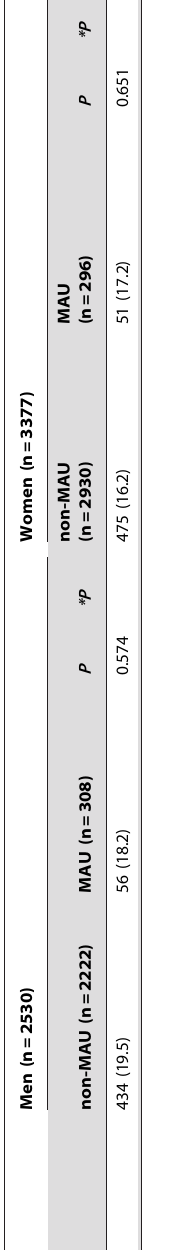
Basic Characteristics of Participants According to MAU (Table 1) Participants with MAU of both sexes were older than those without MAU (mean 6 SD; 57.1 6 10.9 y vs. 60.8 6 11 y, P , 0.001 in men; 57.7 6 10.6 y vs. 61.8 6 10.9 y, P , 0.001 in women). The proportion of poor lung function patterns differed between the MAU and non-MAU groups. The proportions of restrictive and obstructive patterns were higher in the MAU group than the non-MAU group (restrictive pattern: 20.1% vs. 10.2%, P , 0.001 in men; 14.2% vs. 9.3%, P = 0.004 in women; obstructive pattern: 27.3% vs. 22.5%, P = 0.002 in men; 8.8% vs. 6.0%, P = 0.033 in women). The percent predicted value of FVC in the non-MAU group was higher than that in the MAU group for both sexes (mean 6 SD: 91.8% 6 11.3 vs. 87% 6 12.2, P , 0.001 in men; 93.6% 6 11.5 vs. 91.1% 6 12.1, P , 0.001 in women). The percent predicted value of FEV1 in the non-MAU group was also higher than that in the MAU group for men (mean 6 SD: 89.8% 6 13.4 vs. 86.6% 6 14.5, P , 0.001 in men), but not for women. The proportion of participants with hypertension was higher in the MAU group than in the non-MAU group for both sexes (65.2% vs. 39.9%, P , 0.001 in men; 65.5% vs. 35.2%, P , 0.001 in women, respectively). Mean SBP level was higher in the MAU group than in the non-MAU group for both sexes (mean 6 SD: 123.2 6 15.3 vs. 130.2 6 16.6, P , 0.001in men, 121.4 6 16.9 vs. 132.2 6 19.4, P , 0.001 in women, unit= mmHg). The proportion of participants with diabetes mellitus was greater in the MAU group than in the non-MAU group for both sexes (38.9% vs. 11.9%, P , 0.001 in men; 24.8% vs. 10.0%, P , 0.001 in women). Mean FBG level was higher in the MAU group than the non- MAU group for both sexes (mean 6 SD: 101.9 6 21 vs. 117.2 6 36.3, P , 0.001 in men; 97.9 6 20.1 vs. 110.4 6 27.8, P , 0.001 in women, unit= mg/dL). Median triglyceride level was higher in the MAU group than in the non-MAU group for both sexes (median [interquartile range]: 131.0 [92.0–194.0] vs. 145.0 [92.5–225.0], P = 0.049 in men; 108.0 [75.0–155.5] vs. 126.0 [80.0–193.0], P , 0.001 in women, unit =mg/dL). The proportion of overweight women was higher in the MAU group than in the non-MAU group (48.7% vs. 34.9%, P , 0.001). No differences in the lifestyle factors of smoking history, heavy alcohol consumption, and physical activity were observed between participants with MAU and without MAU of either sex. In age-adjusted comparisons, mean DBP level is higher in MAU group than that in non-MAU group for men (age adjusted P ,